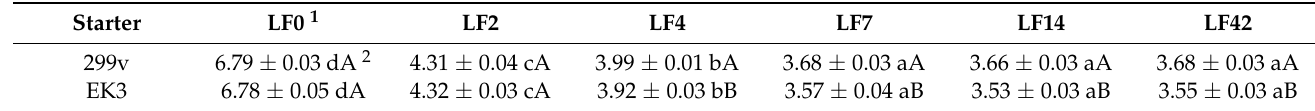
Table 1. Evolution of pH values in fermented